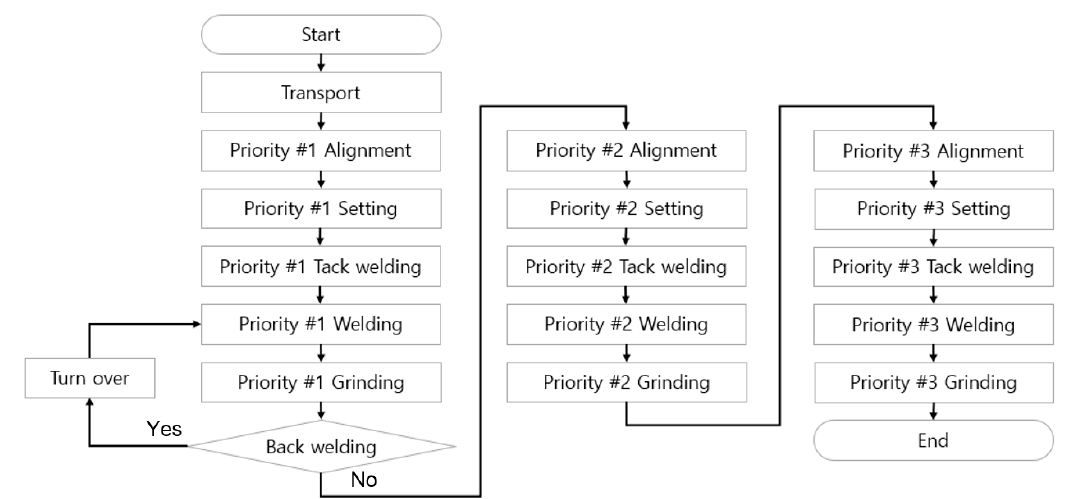
Figure 5. Assembly procedure: Priority #1 for assembly between base plates, priority #2 between base plate and structural members, and priority #3 between structural members.